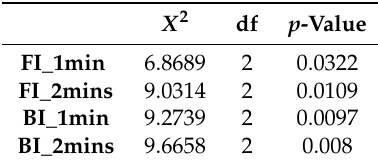
Table 13. Kruskal–Wallis rank sum